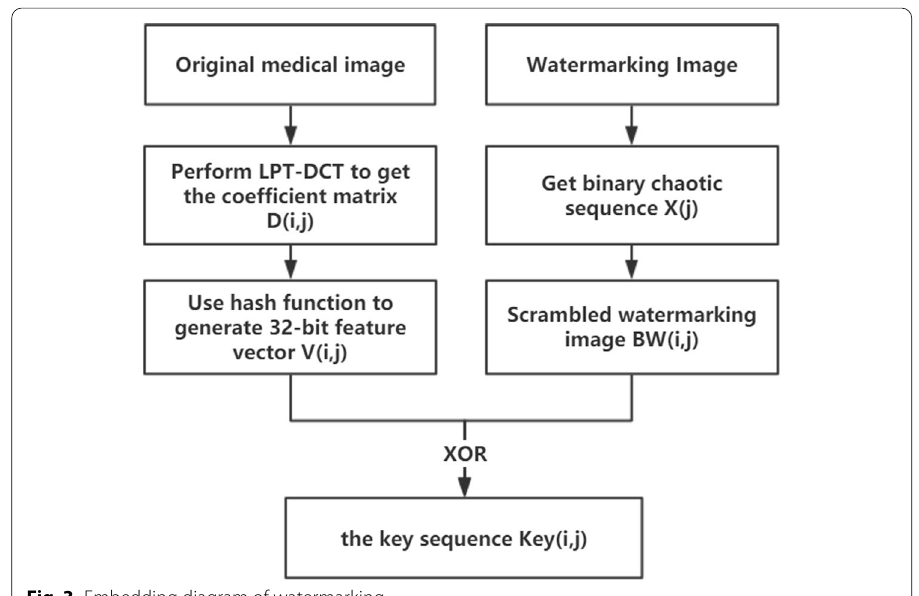
Fig. 3 Embedding diagram of